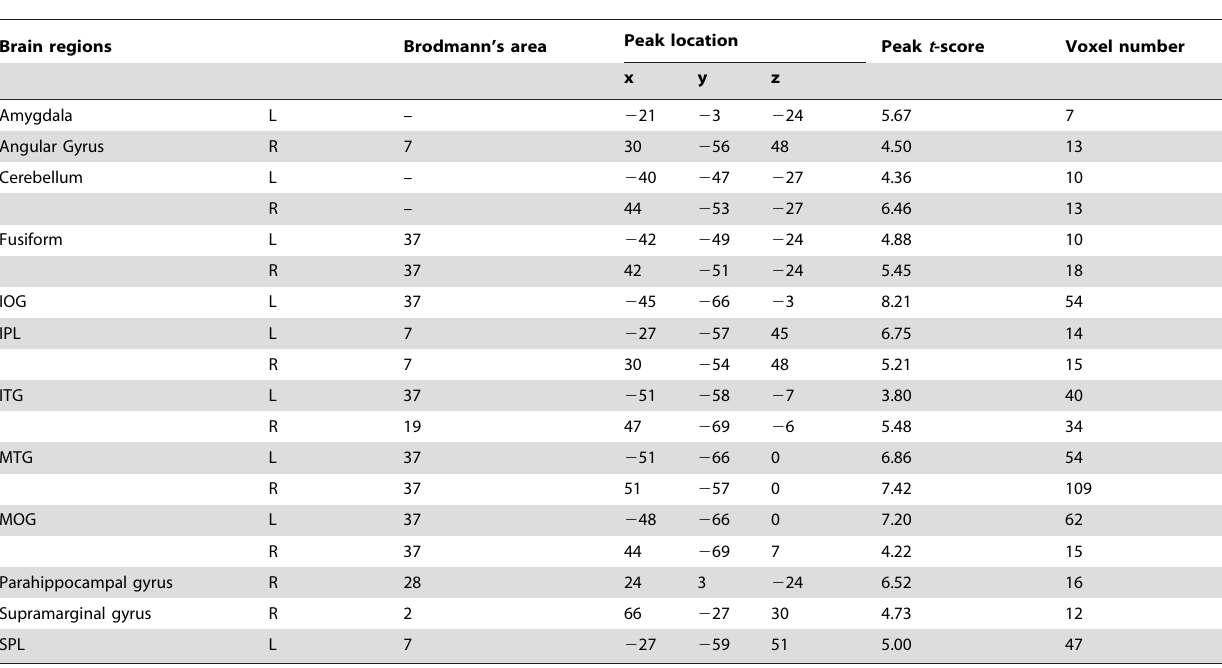
Table 2. Activated brain regions for the LA group in response to heroin-related vs. neutral cues.